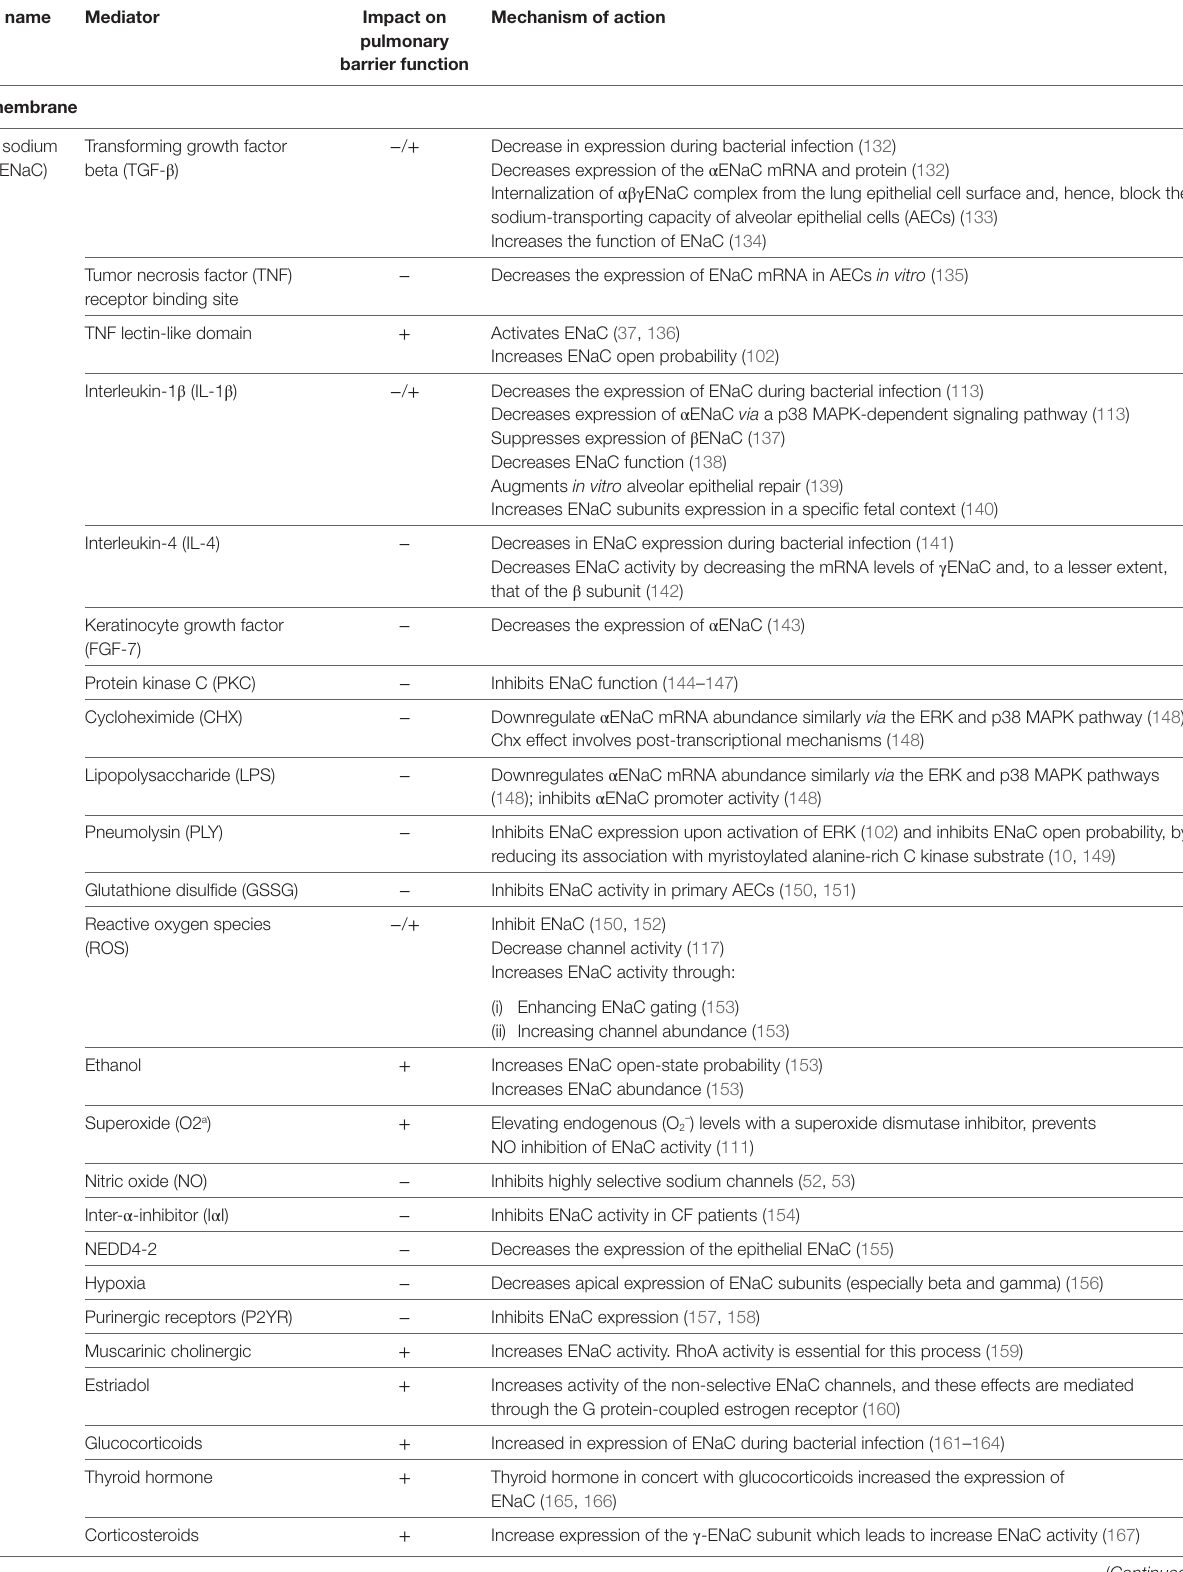
TAbLe 1 | Role of different mediators on fluid transport through impacting on ion channels in the apical and basolateral membrane of epithelial cells. Channel